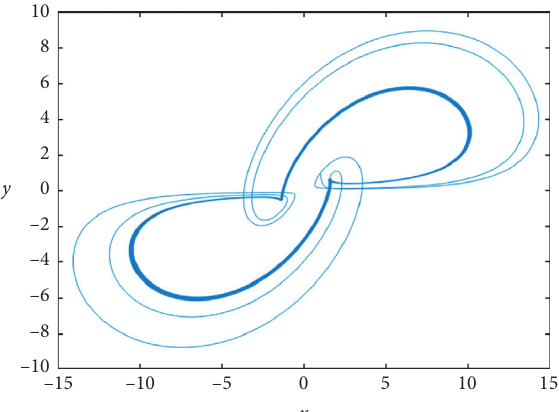
Figure 20: Dynamics of the fractional-order system in (13)–(15) with the order α � 0 . 92, in context of x and y directions.